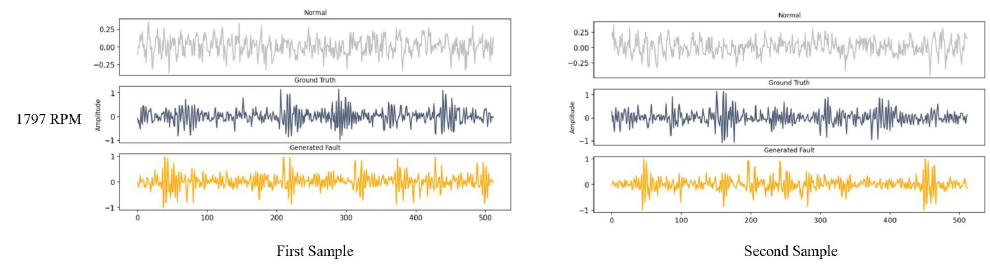
Figure 7. Some samples of generated fault data in 1797 RPM.